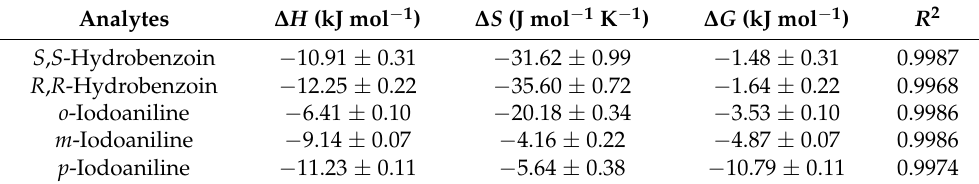
Figure 7. Van’t Hoff curves obtained for ( a ) hydrobenzoin and ( b ) iodoaniline.